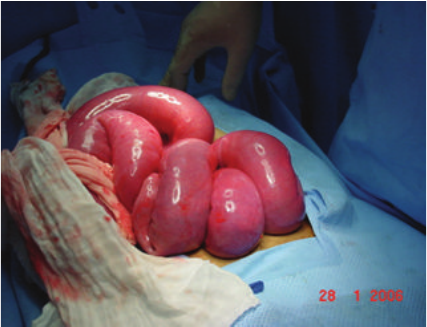
Figure 4: Showing some freed